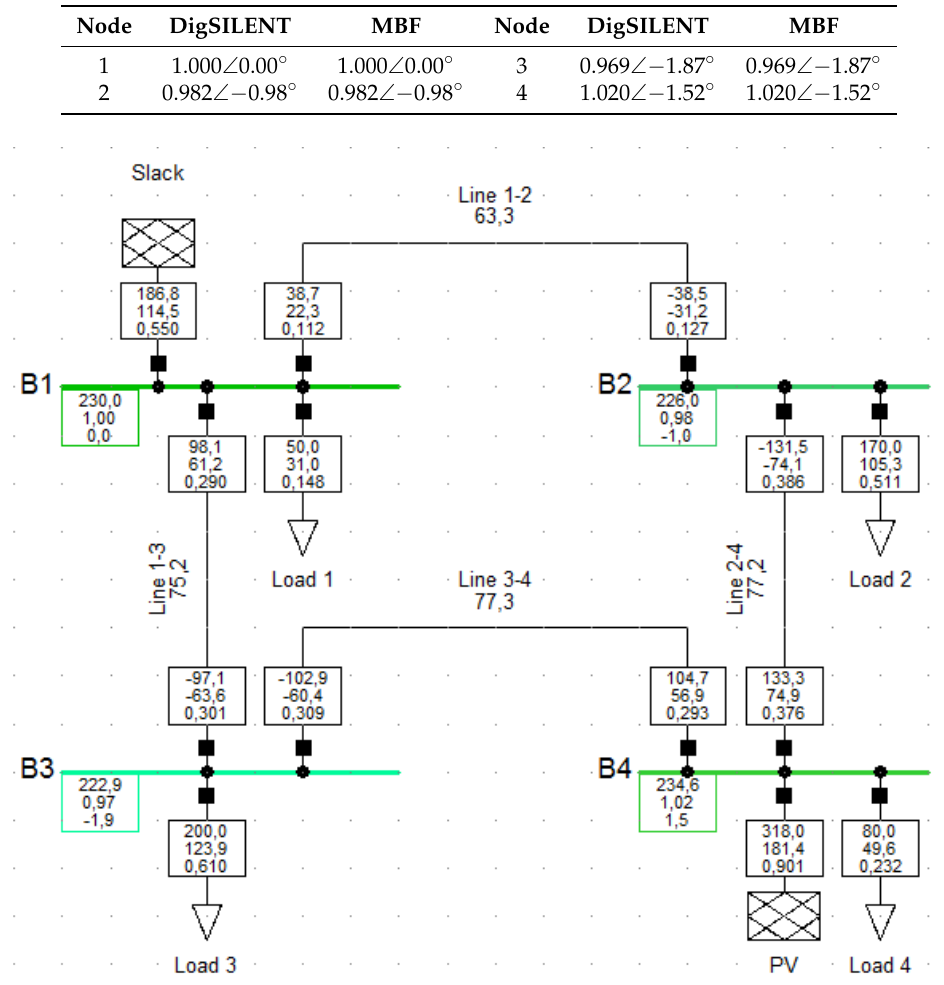
Table 8. Voltages in the four-node test feeder.